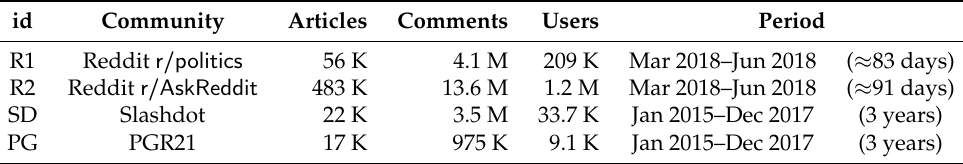
Table 3. Datasets used in this paper